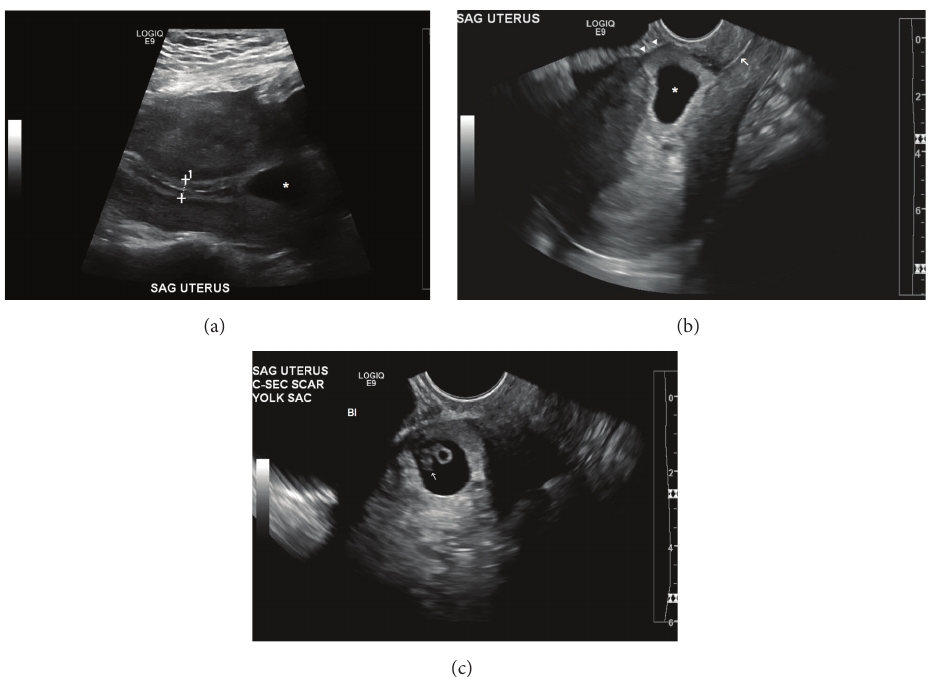
Figure 1: Cesarean section scar ectopic pregnancy. (a) Sagittal transabdominal image shows gestational sac ( ∗ ) in lower uterus inferior to trilaminar endometrium (cursors). (b) Sagittal transvaginal sonogram of gestational sac ( ∗ ) within the lower anterior wall and superior to the cervical canal (arrow). Note the marked thinning of the uterine wall adjacent to the sac (arrowheads). (c) Sagittal transvaginal sonogram of yolk sac and embryo (arrow) within the gestational sac (Bl: urinary